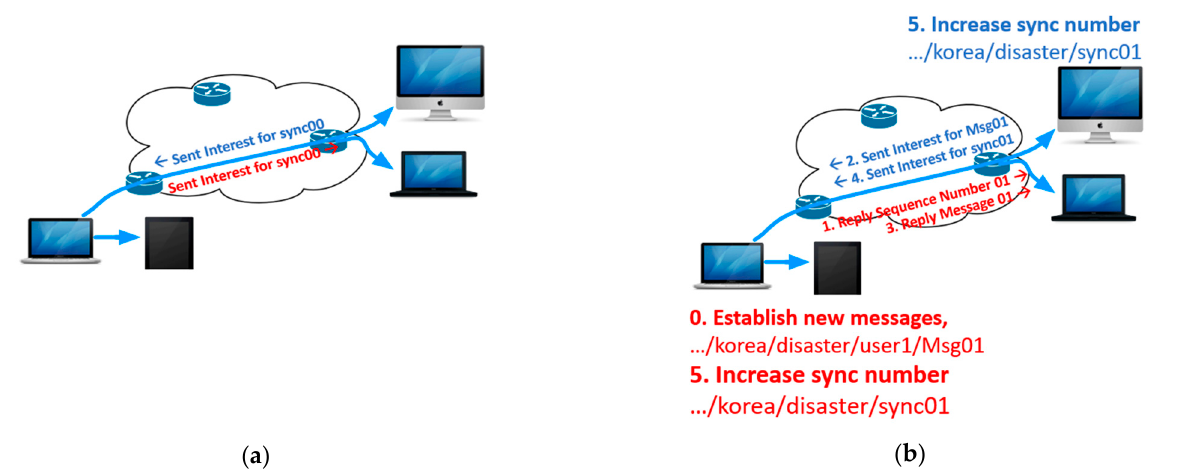
Figure 5. NDN emergency group message delivery: ( a ) Balance state; ( b ) New message state. Table 1. Emergency group communication namespace.